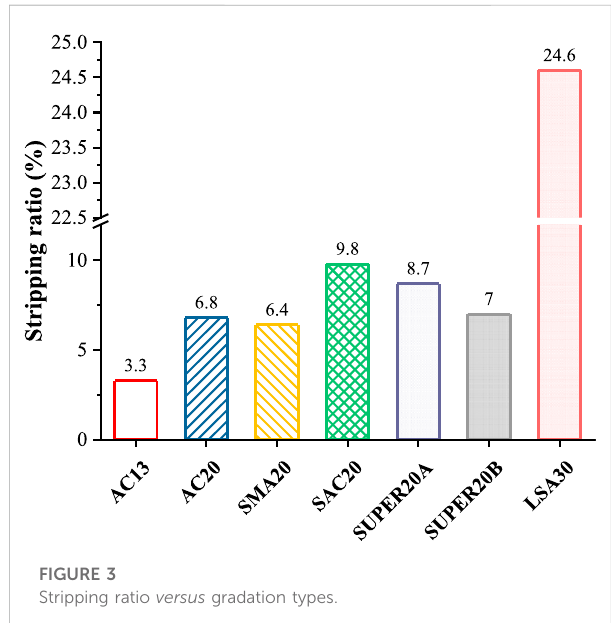
FIGURE 3 Stripping ratio versus gradation